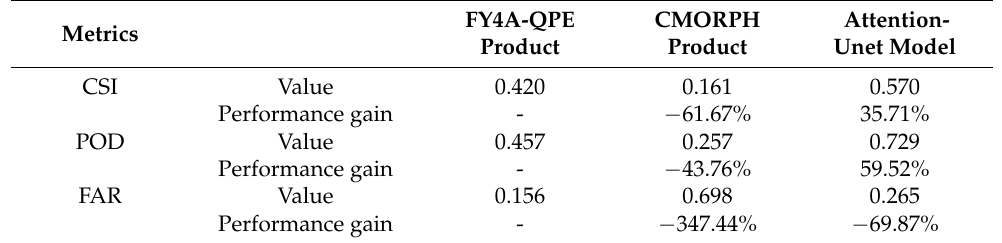
Table 6. Summary of precipitation identification performances over extreme precipitation events.